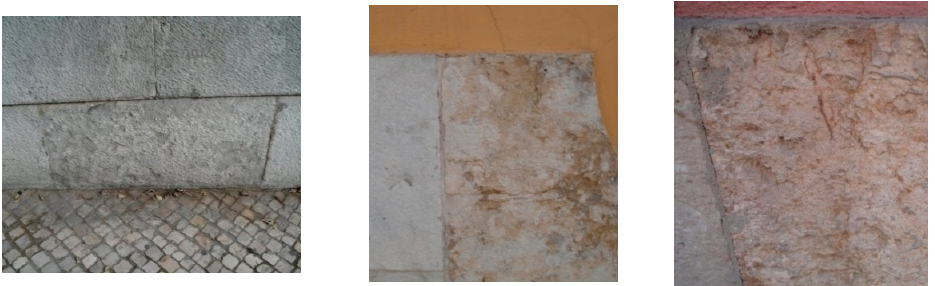
Figure 6. Illustrative examples of the loss of integrity anomalies observed in NSC located at the bottom wall of NSC façades.